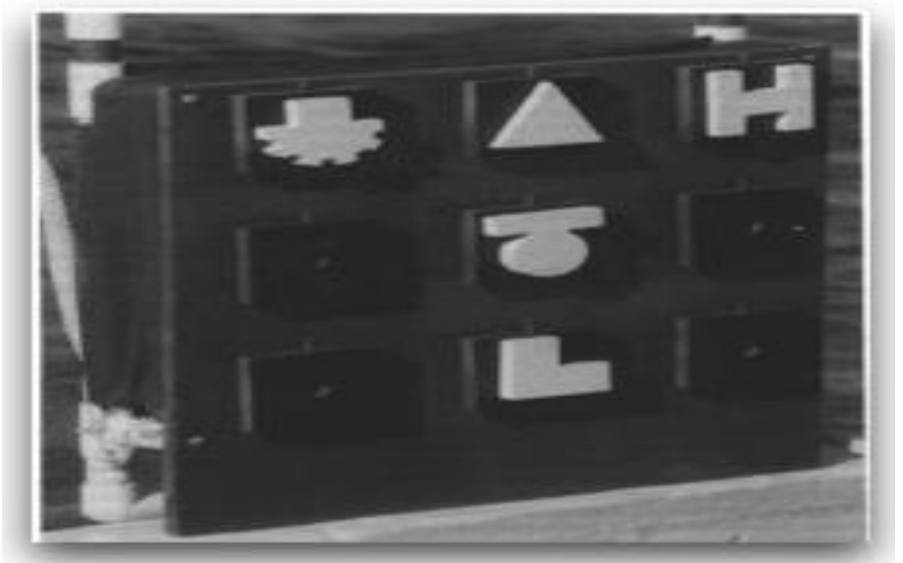
Figure 2. Tank-side keyboard with physical visual symbols and associated sounds used at MarineWorld Africa